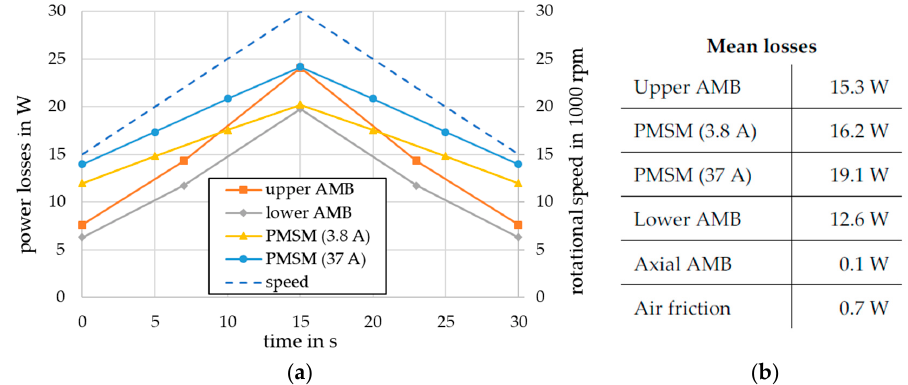
Figure 8. ( a ) Rotational speed and calculated rotational losses of the active components during one cycle; ( b ) Resulting mean losses of all calculated loss mechanisms in the rotor during